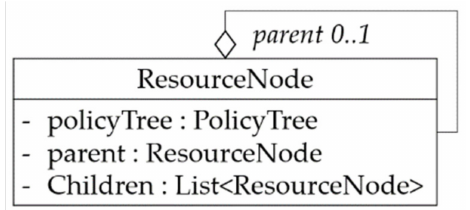
Figure 1. Resource Tree Class